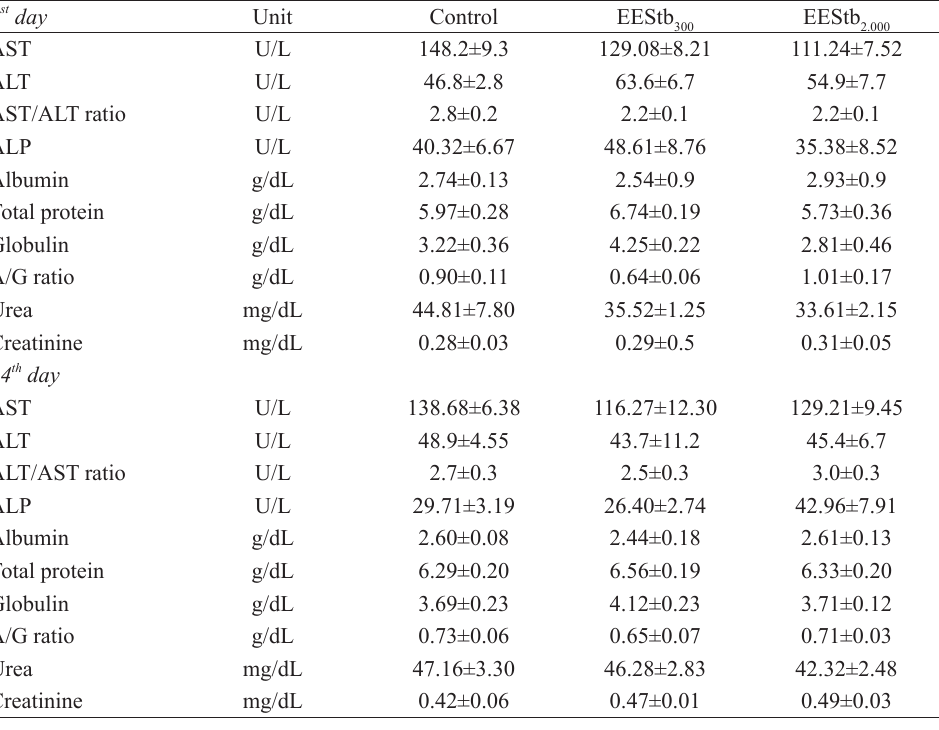
Effects of acute oral treatment with the EEstb on biochemical parameters of control (C), treated ) and 2.000 mg/kg (EEstb ) groups at 1 st and 14 th day after gavage. with 300 mg/kg (EEstb 300 2.000